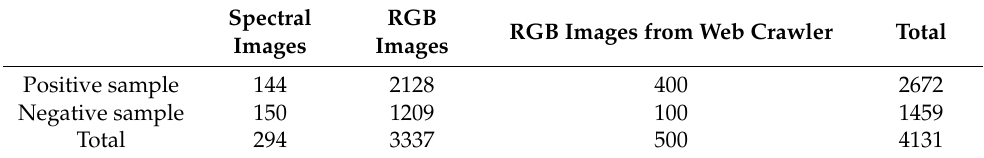
Table 2. Quantitative analysis of coral classification dataset.